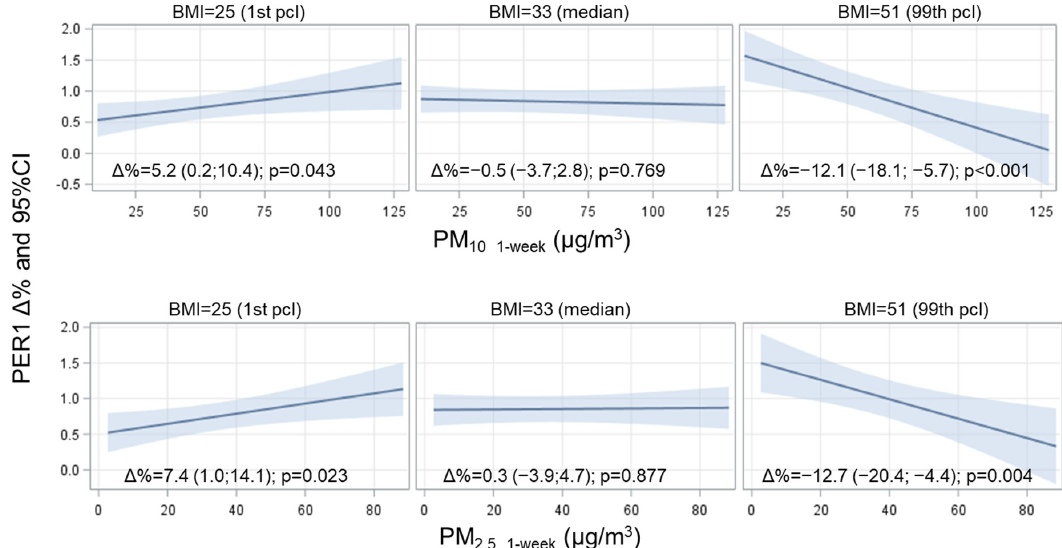
Figure 3. Interaction effect of PM and BMI on PER1 methylation level. The strength of the association between PM and PER1 at three selected levels of BMI (1st, 50th, and 99th percentile) is presented. Estimates were calculated from multivariate models adjusted for age, BMI, smoking habits, percentage of lymphocytes, Pyrosequencing run, CpG site, season, temperature, and humidity. Adjusted delta percent changes ( ∆ %) are reported for 10 µ g/m 3 increases in PM concentration. The p -values for the interaction term with BMI were p = 0.001 for PM 10 , and p < 0.001 for PM 2.5 . To produce the estimate, we entered the levels of PM into the equation along with the range of values for PER1 , at the mean value of continuous covariate, and selected levels for categorical variables.